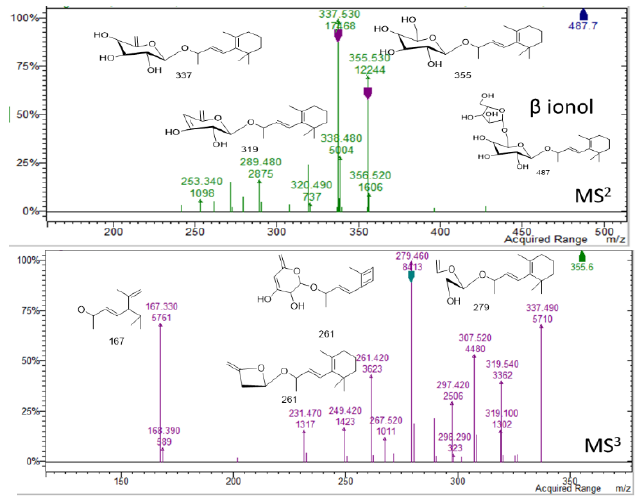
Figure 8. Mass spectral details of dihydro β ionol- O -[arabinosil(1-6) glucoside]. Further compounds presenting molecular ion [M − H] − at m/z 663 were assigned to ester of sucrose with ferulic acid and p -coumaric acid. Five different isomers (26–30) were observed, probably due to the ester linkages at different positions. From MS spectra, it is not possible to assign the different isomers due to lack of specific literature.